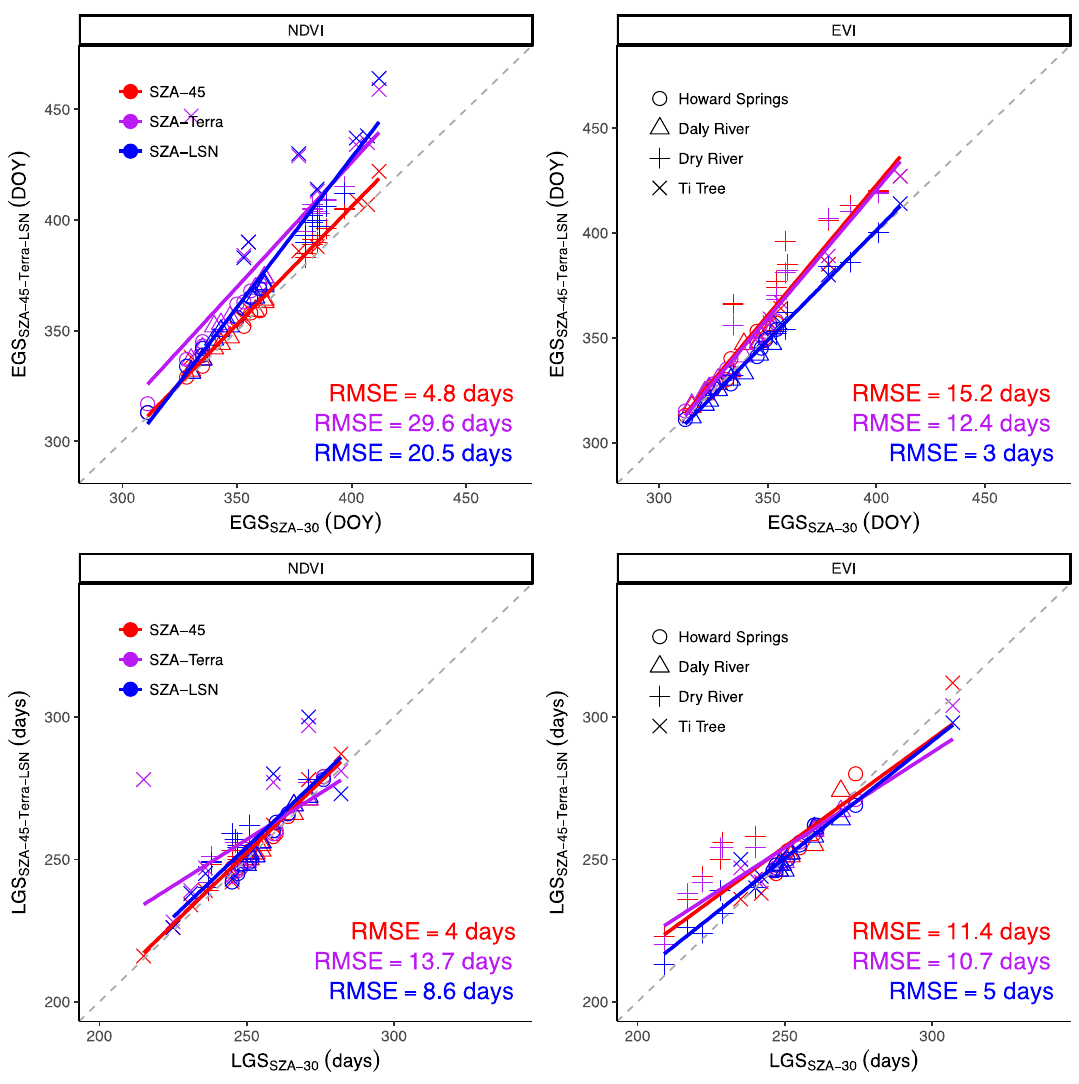
Figure 11. Cross-site relationship between the phenological metrics extracted from NDVI and EVI, with different SZA configurations across four NATT sites. EGS—end of greening season; LGS—length of greening season; And DOY—day of year, started on July 1. Phenological metrics extracted from NDVI and EVI with three different SZA configurations (all at nadir view), with SZA varying according to Terra overpassing time (SZA-Terra) and local solar noon (SZA-LSN), or fixed at 30° (SZA-30) or 45° (SZA-45).